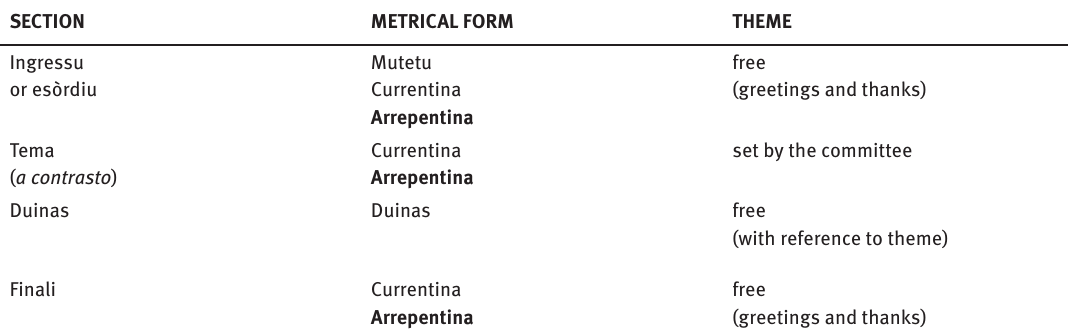
SECTION METRICAL